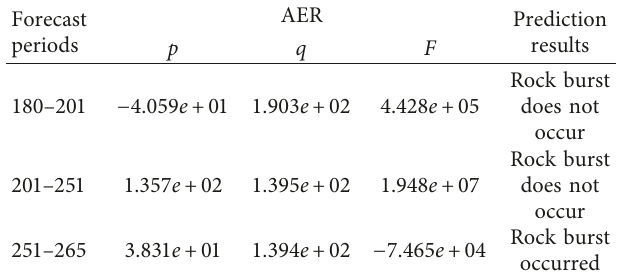
Table 4: Rock burst prediction of cylindrical red sandstone.